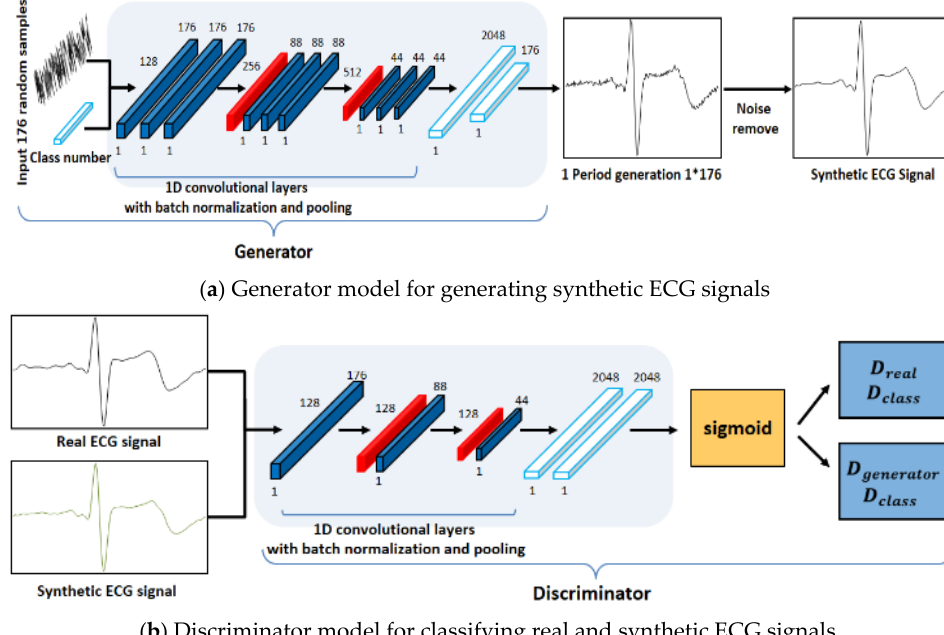
Figure 4. Proposed generator and discriminator network structures.